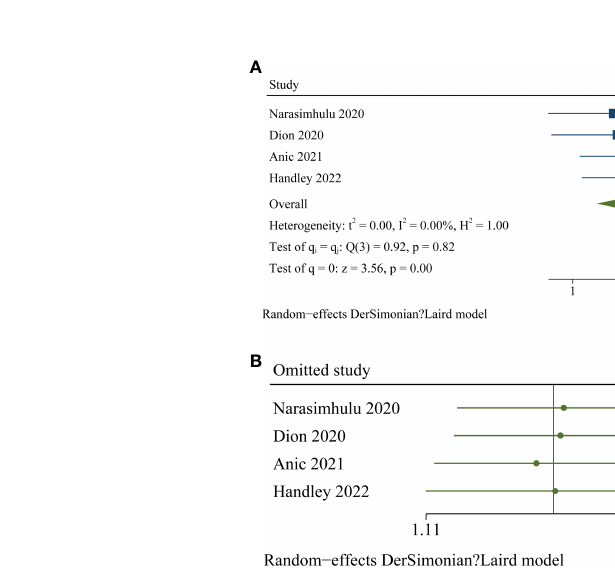
FIGURE 3 Forest plots for the meta-analyses regarding the association between high frailty and PFS in patients with OC. (A) , overall meta-analysis; (B) , in fl uencing analysis by omitting one study at a time.